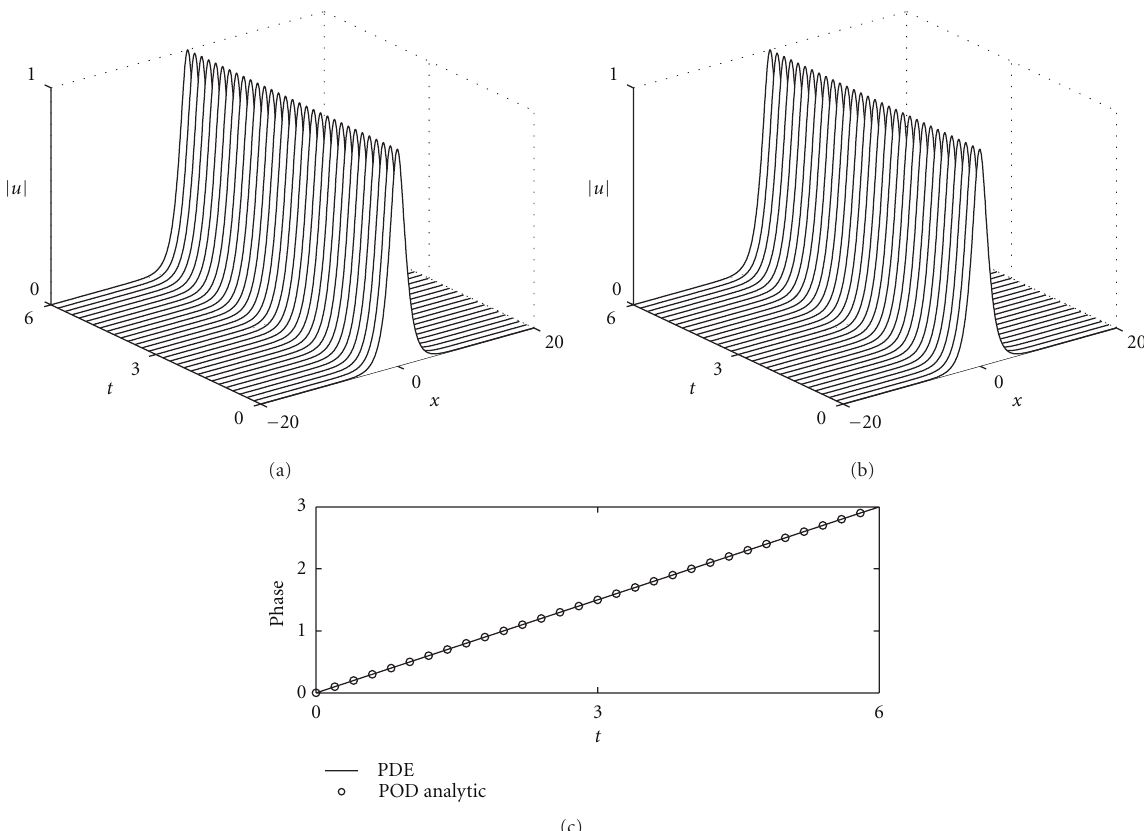
Figure 5: Comparison of (a) full PDE dynamics and (b) one-mode POD dynamics. In the bottom figure, the phase of the pulse evolution at x = 0 is plotted for the full PDE simulations and the one-mode analytic formula (circles) given in (18).